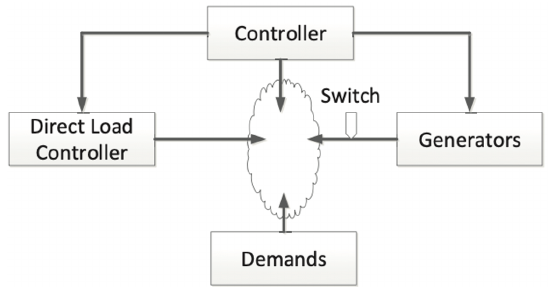
Figure 12. A simplified model of the power grid